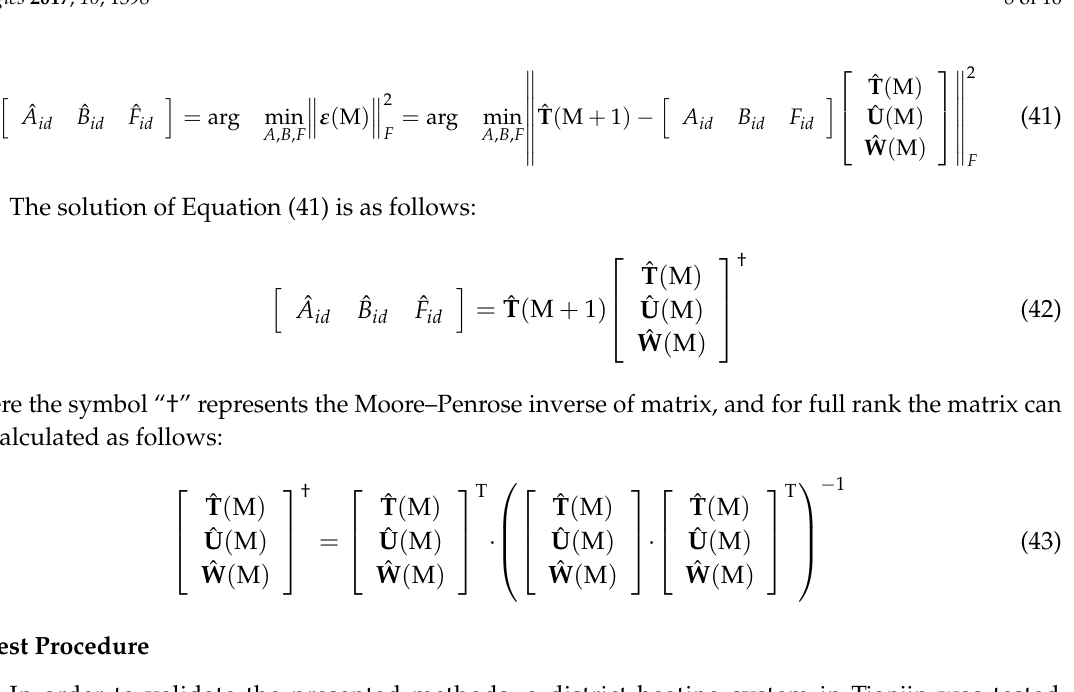
Figure 3. HISAKA PHE in the district heating system.